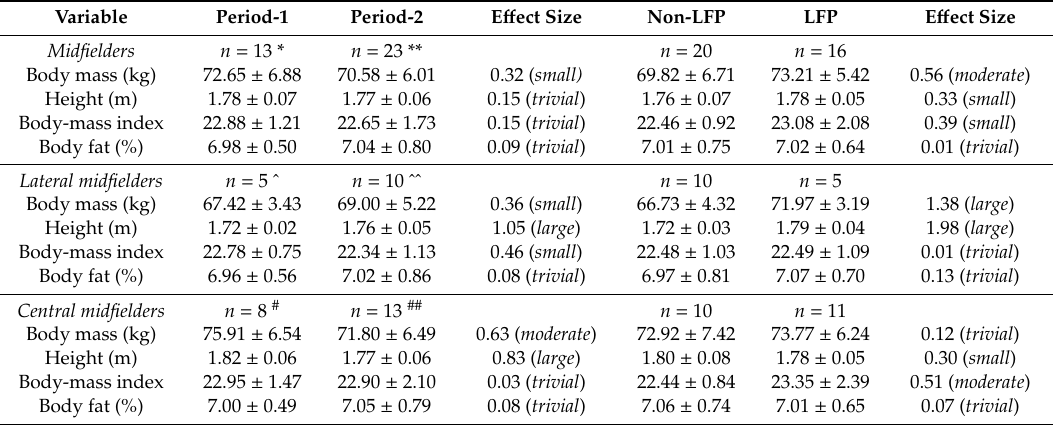
Table 3. Comparison of the anthropometric profile of midfielders in Period-1 (2008 / 2009–2012 / 2013) with that of midfielders in Period-2 (2013 / 2014–2017 / 2018) and of Spanish non-LFP players with that of Spanish LFP players (2008 / 2009–2017 / 2018).